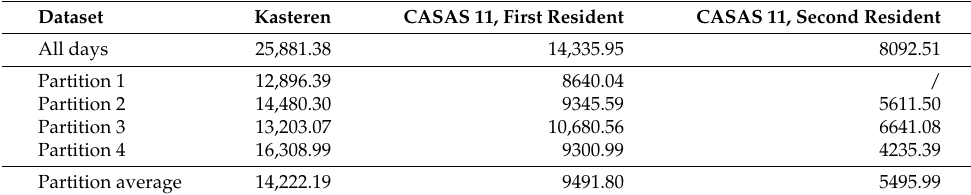
Table 5. Average Hamming distances H3 between all days and days in the same